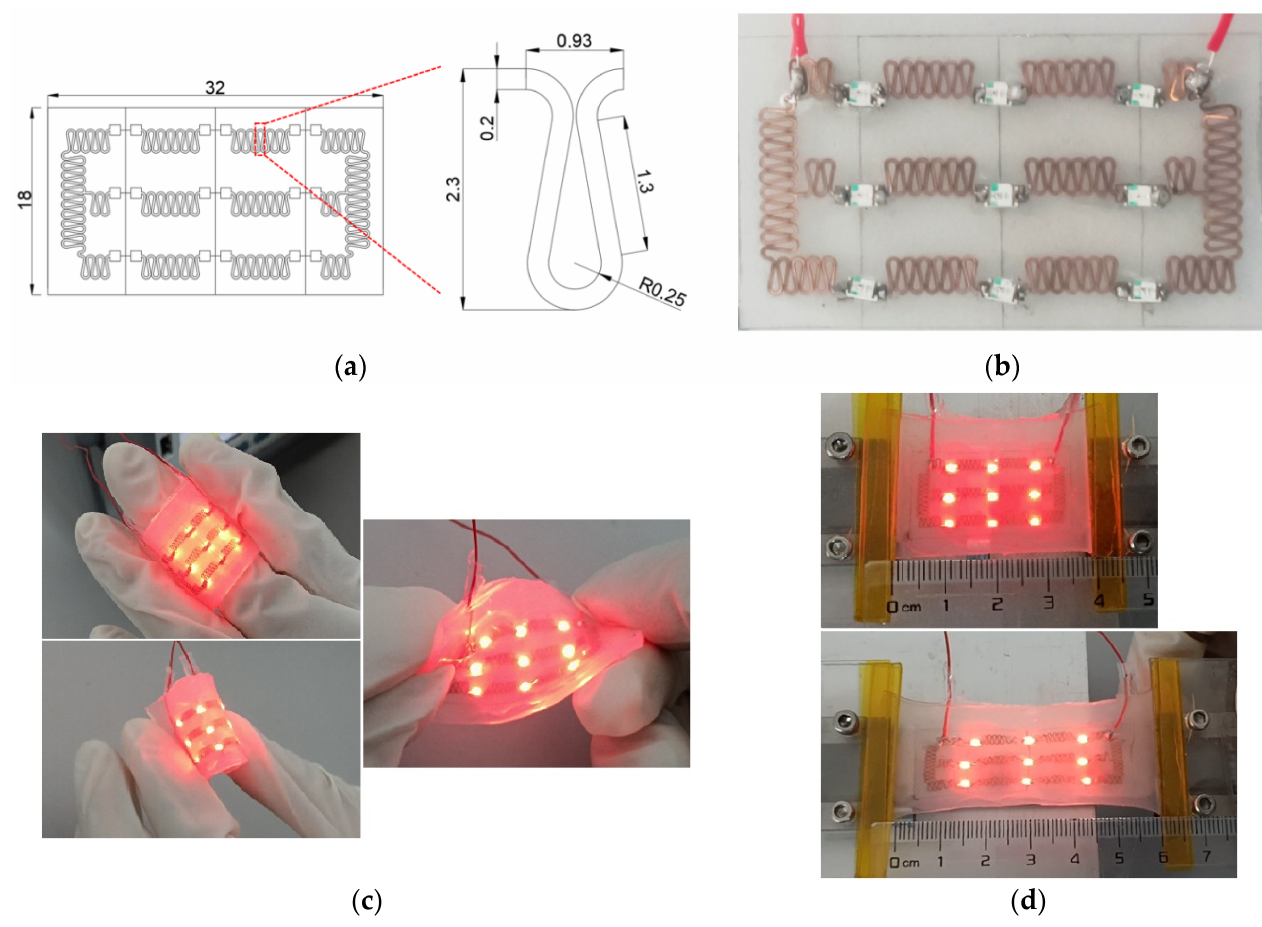
Figure 11. Stretchable LED array. ( a ) LED array circuit structure; ( b ) packaged LED array; ( c ) bending and torsion tests; ( d ) tensile test.